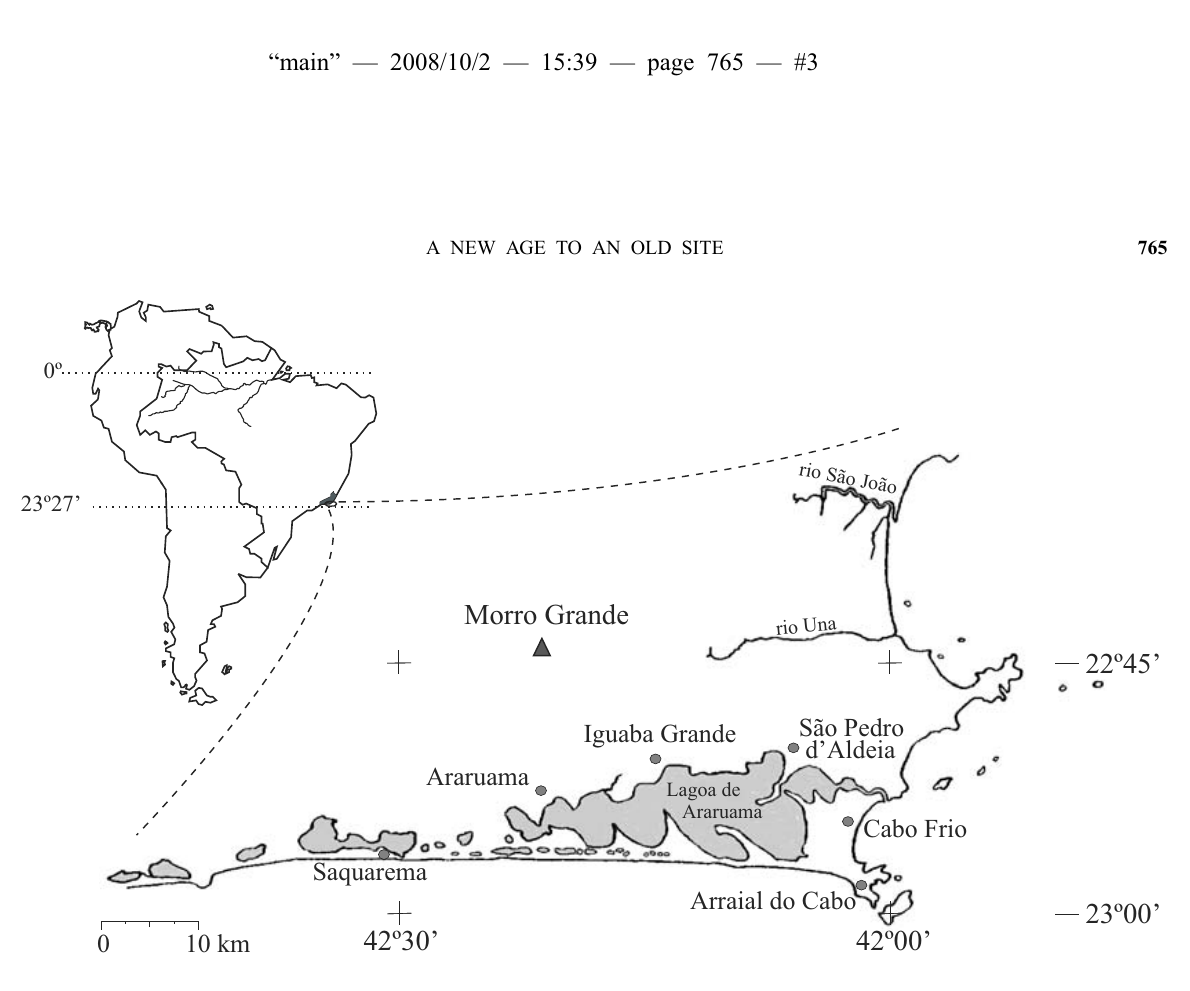
Fig. 1 – Geographical location of the study